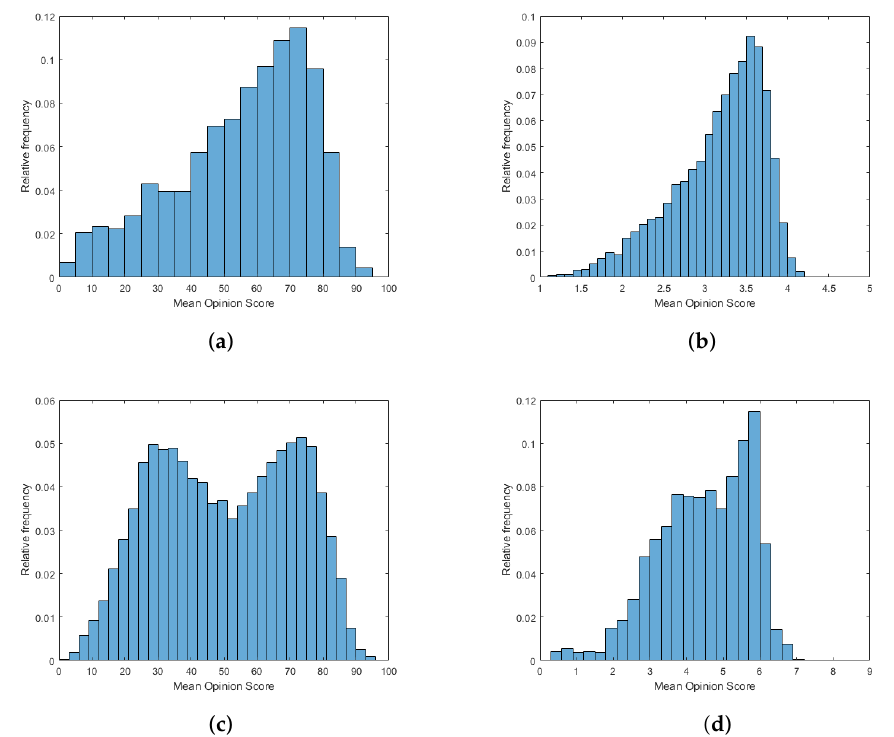
Figure 1. MOS distributions in the applied benchmark IQA databases: a) CLIVE [50], b) KonIQ-10k [4], c) SPAQ [5], and d) TID2013 [51].